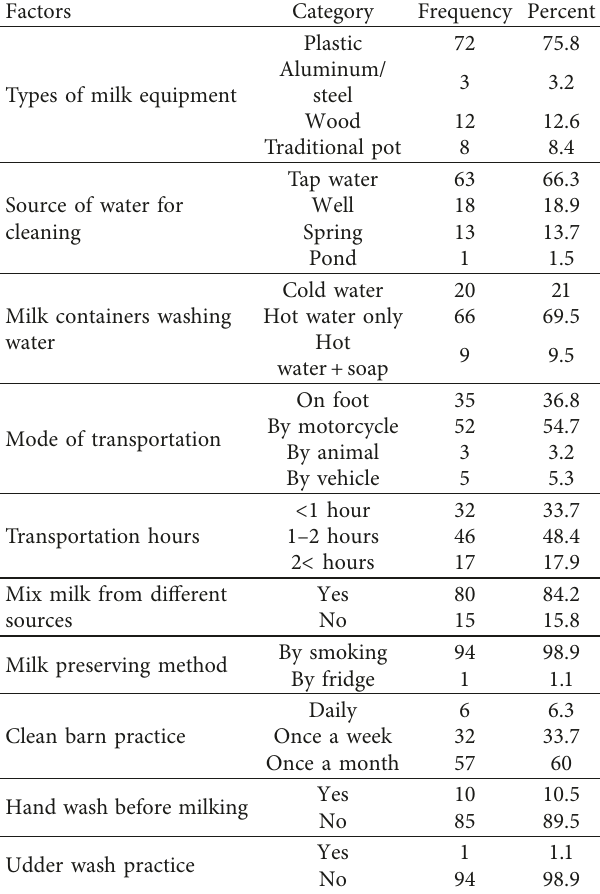
Table 2: Hygienic practices, environment, transportation, and milk container characteristics among milk owners in the Borena zone Gomole district, southern Ethiopia,